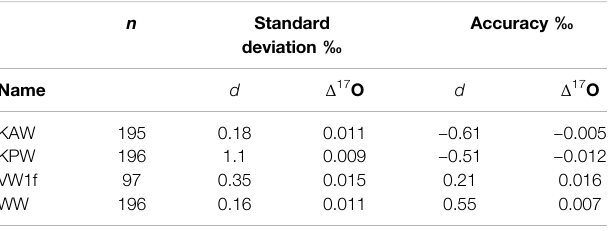
TABLE 4 | Precision and accuracy of deuterium excess and 17 O excess for reference waters measured as unknowns. n (cid:1) number of independent measurements.